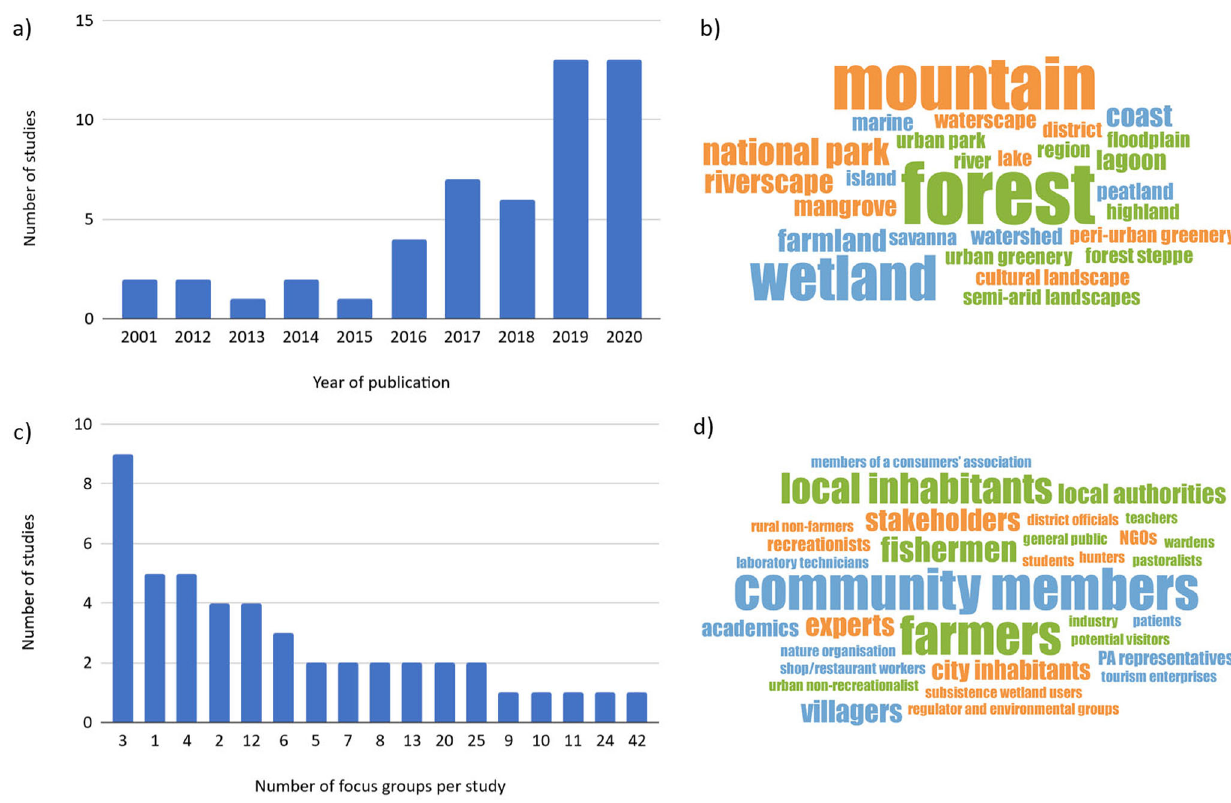
Fig. 4 Characteristics of case studies presenting year of publication, types of study areas, number of focus groups per study, types of participants. a Number of case studies using focus groups in CES research published in academic literature. b Wordcloud presenting various types of study areas (mixture of ecosystems, landscapes, and governance status of study areas based on available data). c Number of focus groups per case study. d Wordcloud presenting various types of participants in focus groups (coded into similar groups as reported in case